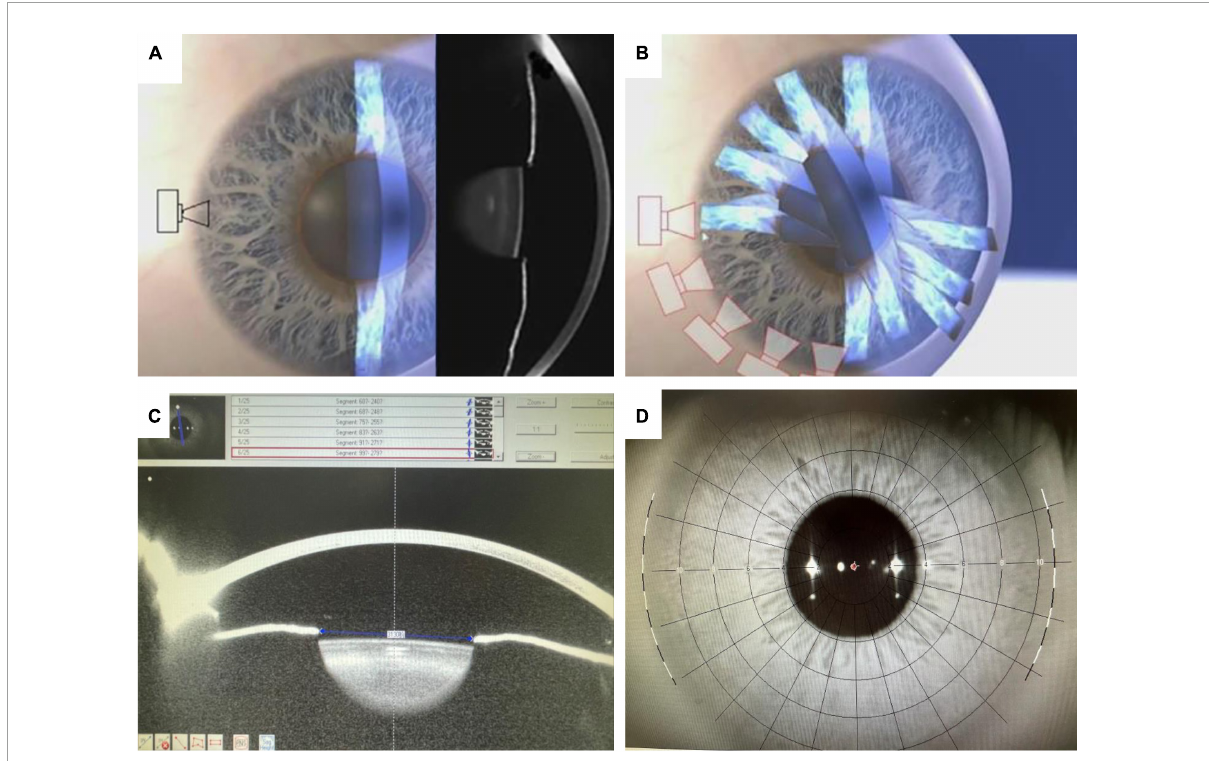
FIGURE1 The data acquisition of Pentacam HR system (A,B) , PD from one of 25 Scheimpflug images on the 99 ◦ meridian (C) , and the iris image (D) : The cross indicating the center of the pupil and the red circle the apex of the